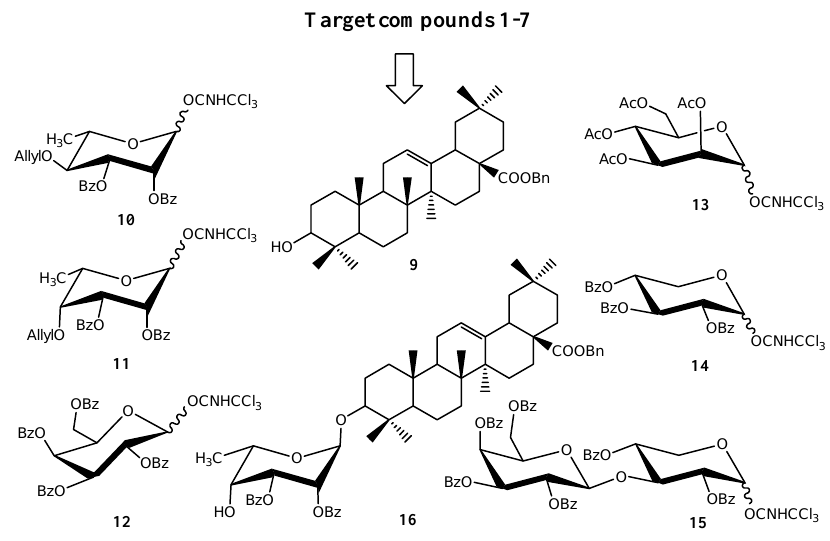
Figure 2. The building blocks 9-16 used for the synthesis of target compounds 1-7